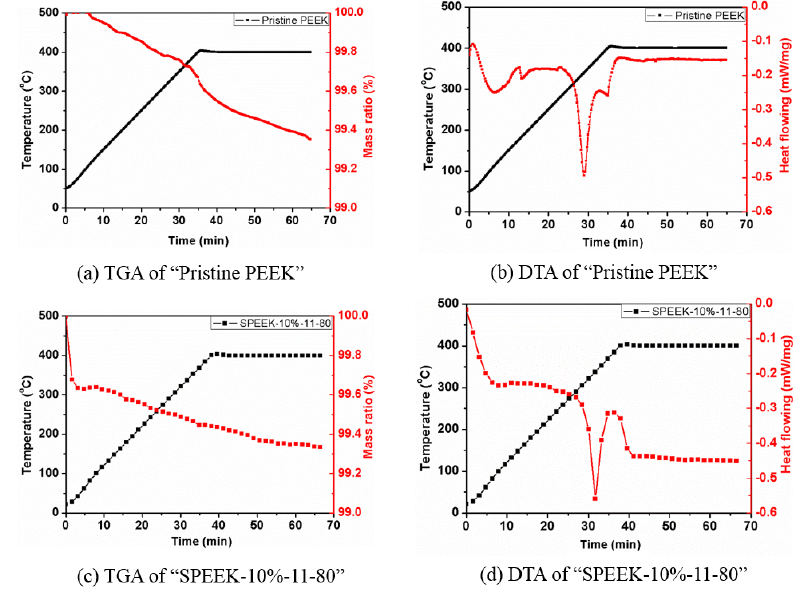
Fig. 3 TGA and DTA profiles of (a, b) pristine PEEK and (c, d) SPEEK-10%-11-80 powders. The sulfonated PEEK powders had good thermal stability and were suitable for the sintering